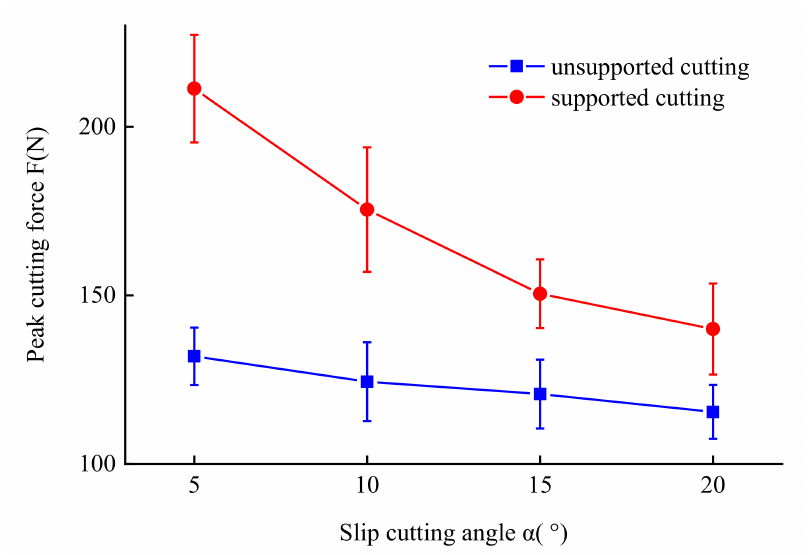
Figure 12. Relationship between tool slip cutting angle and peak cutting force. Note: branch diameter is 9–10 mm; wedge angle is 25 ◦ ; average cutting speed is 3.36 m · s − 1 ; cutting gap is 1 mm; cutting height is 5 cm; moisture content is 25.3%–28.7%.